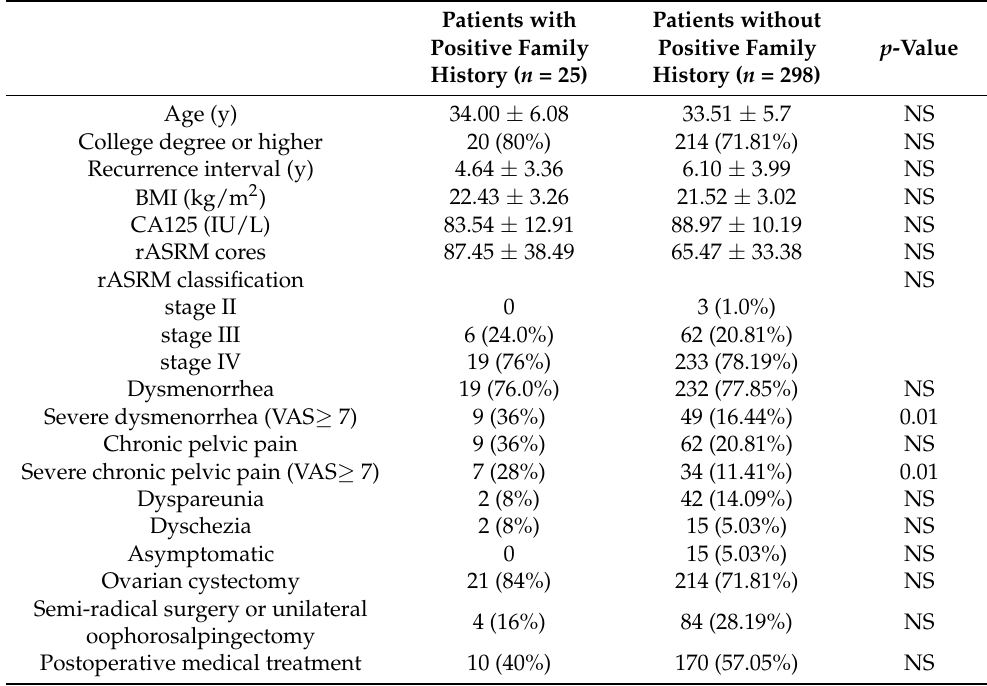
Table 5. Comparison of characteristics between recurrent endometriosis patients with and without family